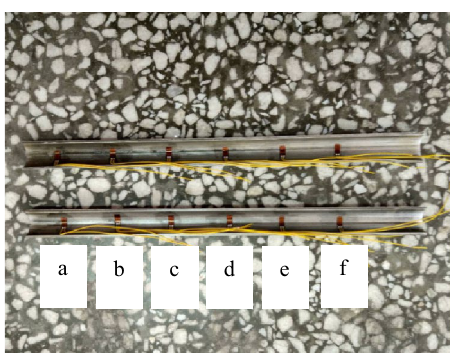
Figure 5. Positions of strain gauges on inner wall of tube.